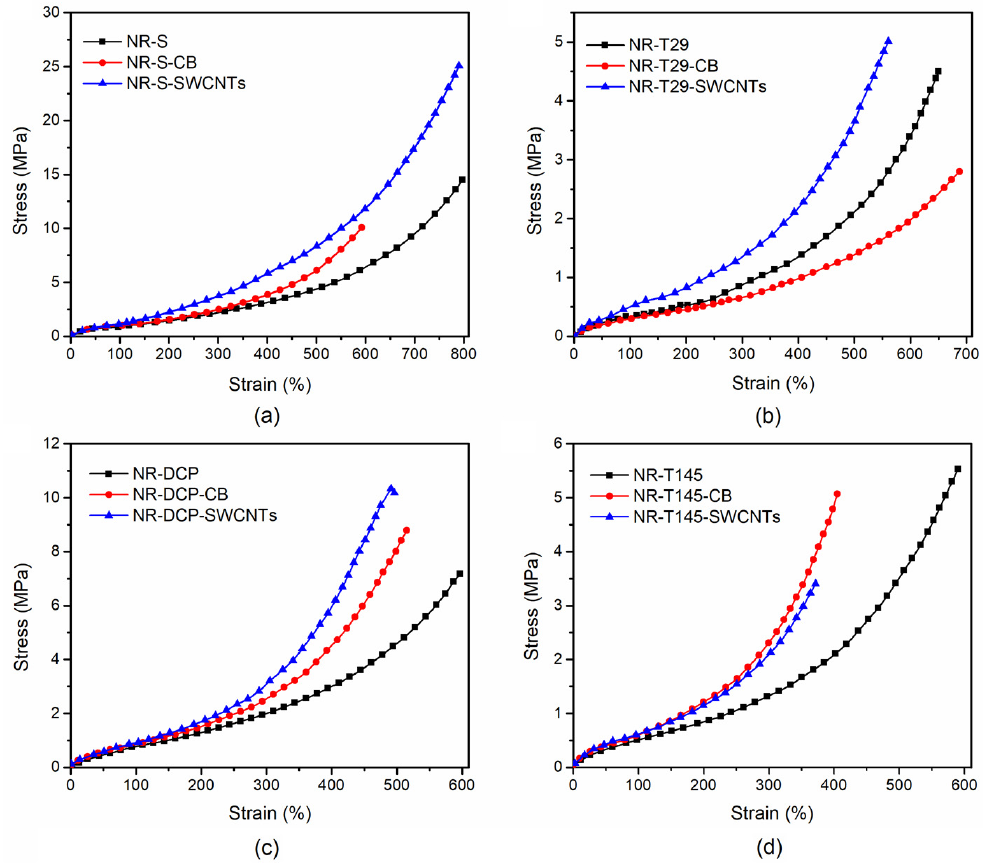
Figure 5. Stress–strain curves of the NR composites vulcanized with different cross-linking agents: